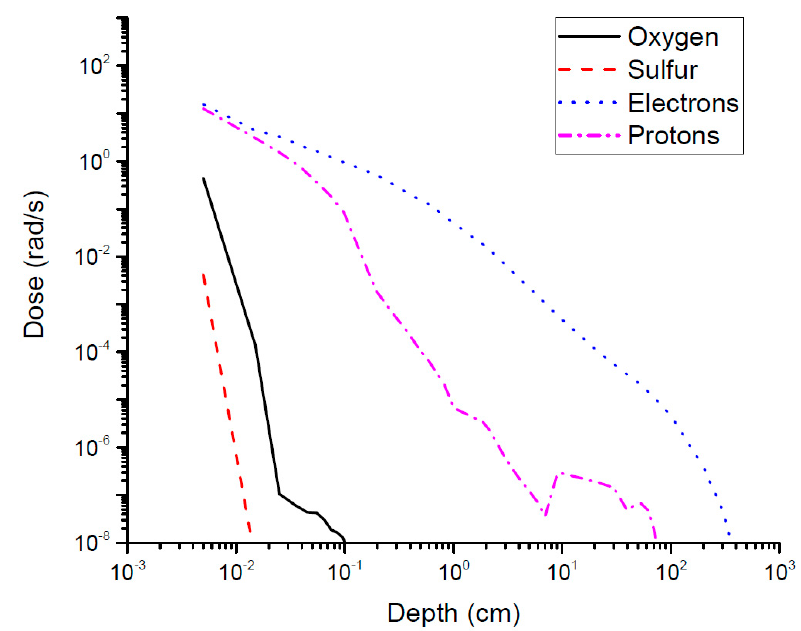
Figure A1. Calculated dose rates for incident particles.